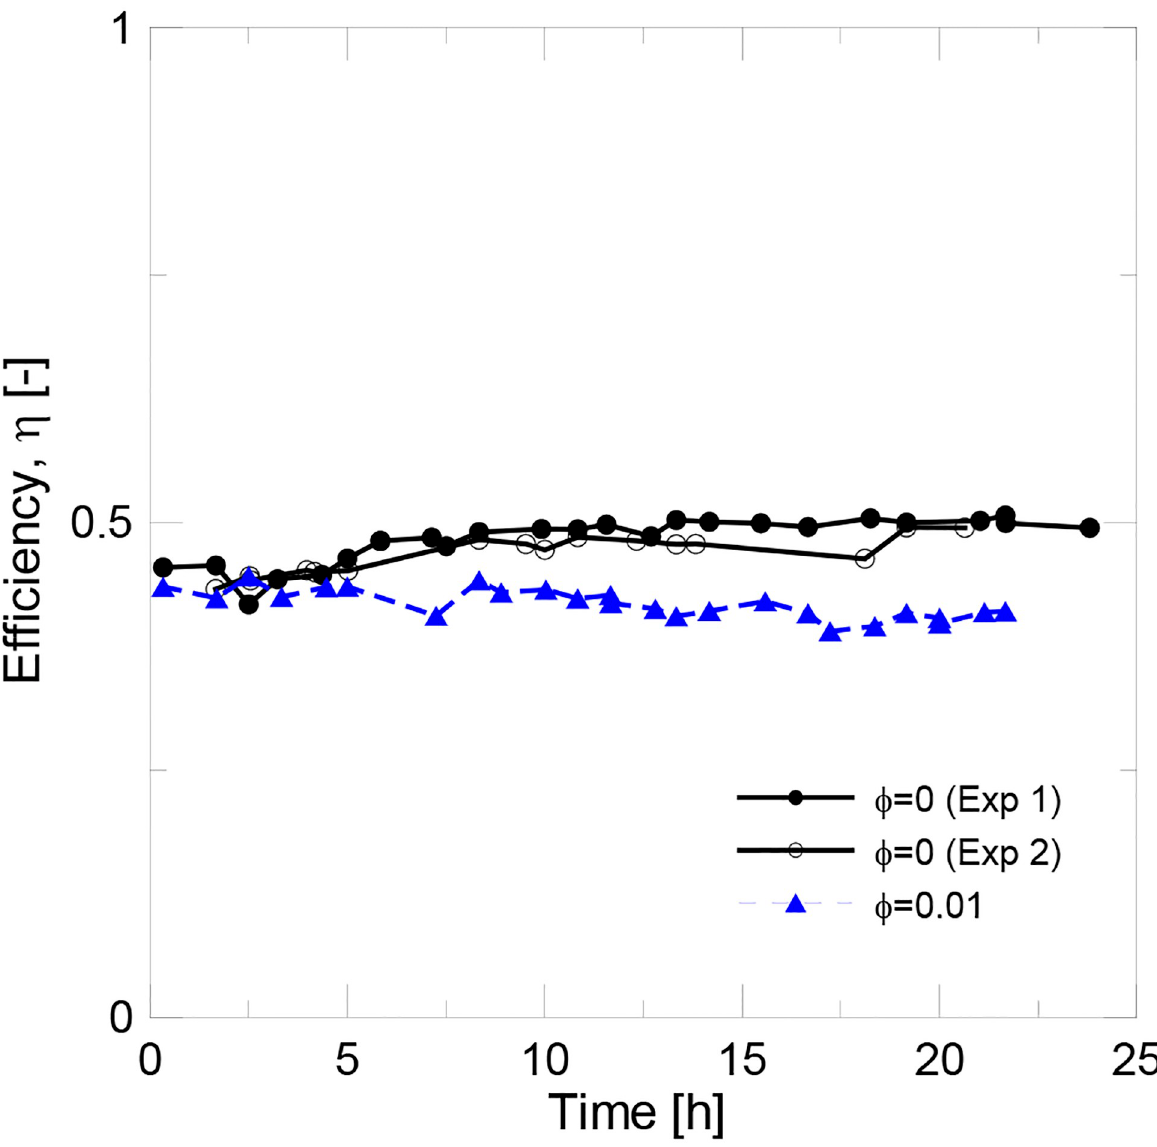
Fig 9. Instantaneous efficiency for water and the alumina nanofluid at 1 v% (2.4